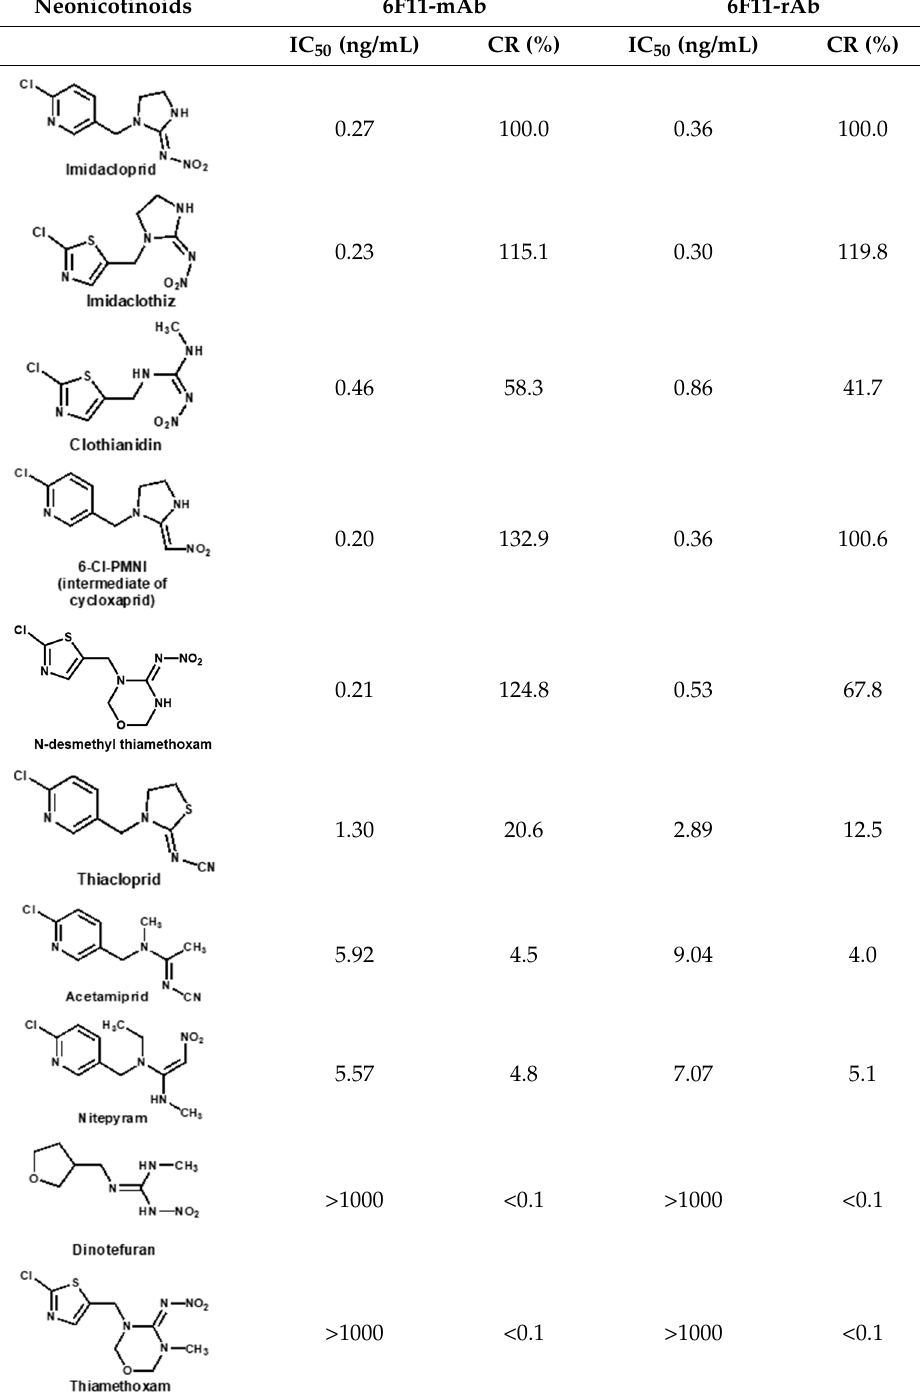
Figure 4. Standard curves for the detection of neonicotinoid pesticides and metabolites by icELISAs based on 6F11-mAb ( A ) and 6F11-rAb ( B ). The error bars represent the standard deviations of the data points ( n = 3). Table 2. Selectivity of 6F11-mAb and 6F11-rAb toward neonicotinoid pesticides and metabolites. Neonicotinoids